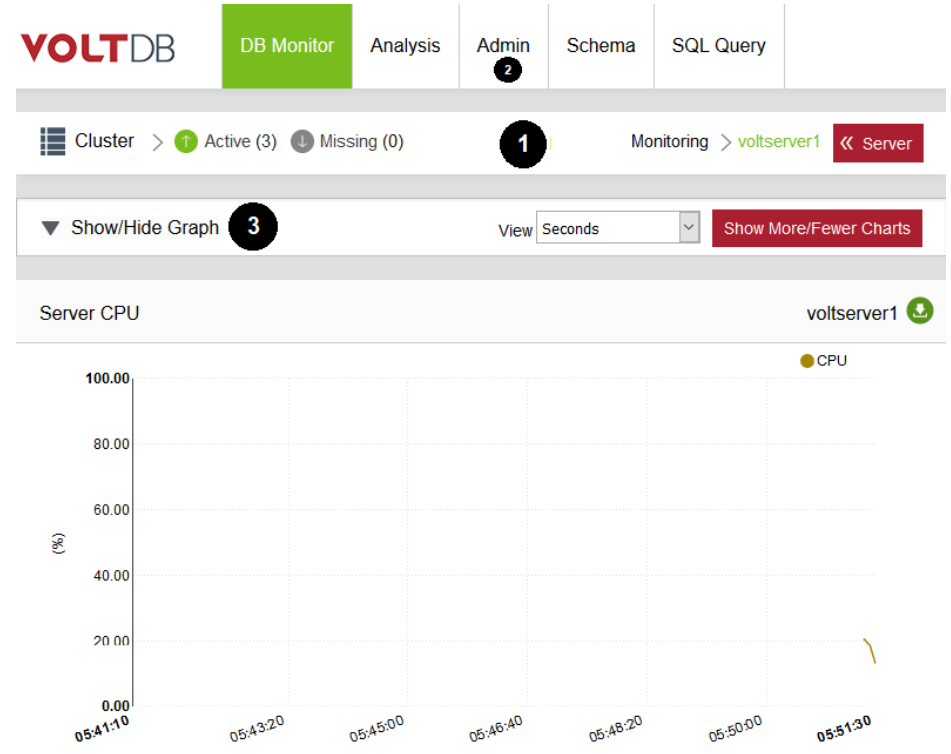
Figure 6. VoltDB v11.3 deployment manager interface.